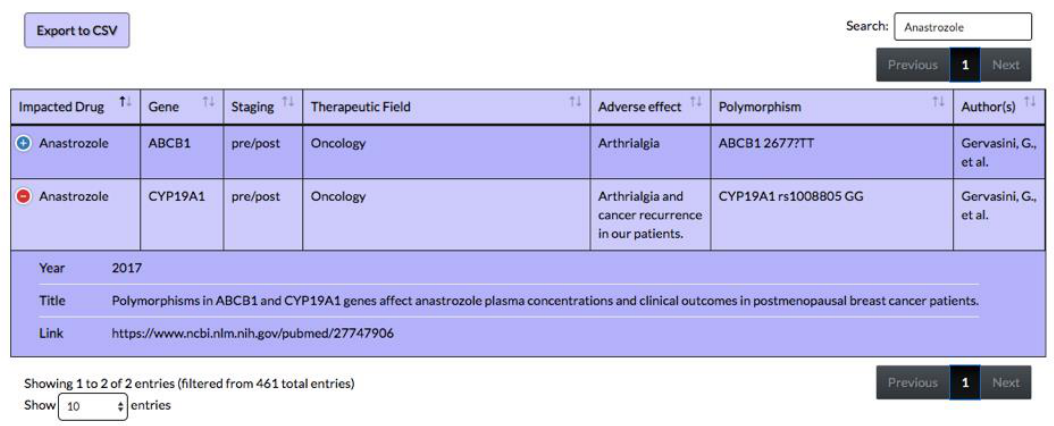
Figure 5. Screenshots of the web-based search tool of pharmacogenetics table, searching for adverse effects of anastrozole on different genes. Expansion of cells using the plus sign provides the source and year of publication of the reference article. The background color is the same as the actual website, color variation is for row separation purpose.